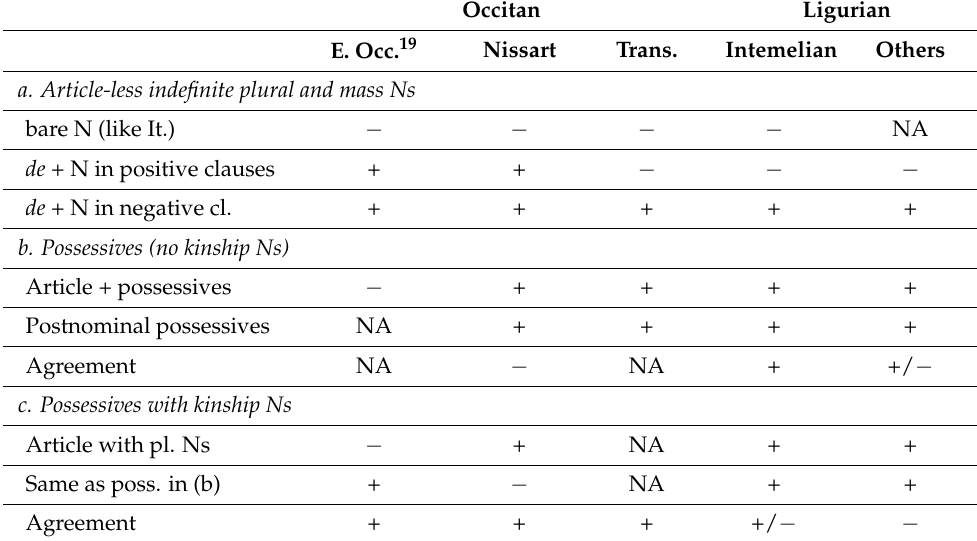
Table 15. Comparison between linguistic areas. The symbols + and − signal the presence vs. absence of the properties listed in the first column; NA means that I do not have enough data to draw a solid